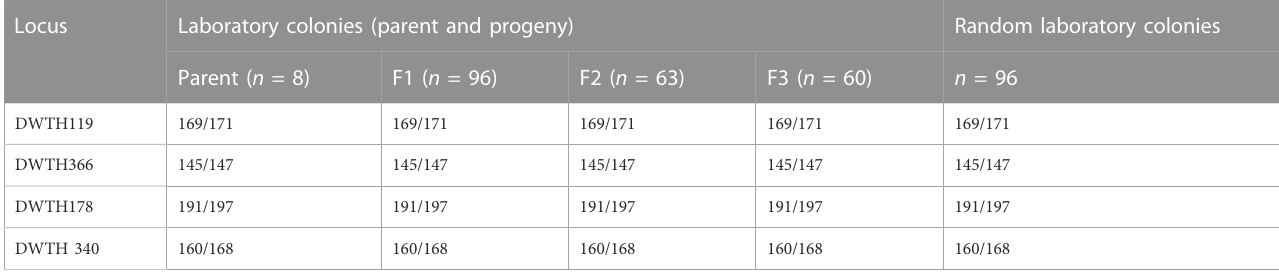
TABLE 4 Genotypes of parent, progeny, and random individuals of thelytokous D. wani .The numbers before and after the virgule indicate alleles in the species, where diploid females have two alleles and haploid males carry only one allele. Locus Laboratory colonies (parent and